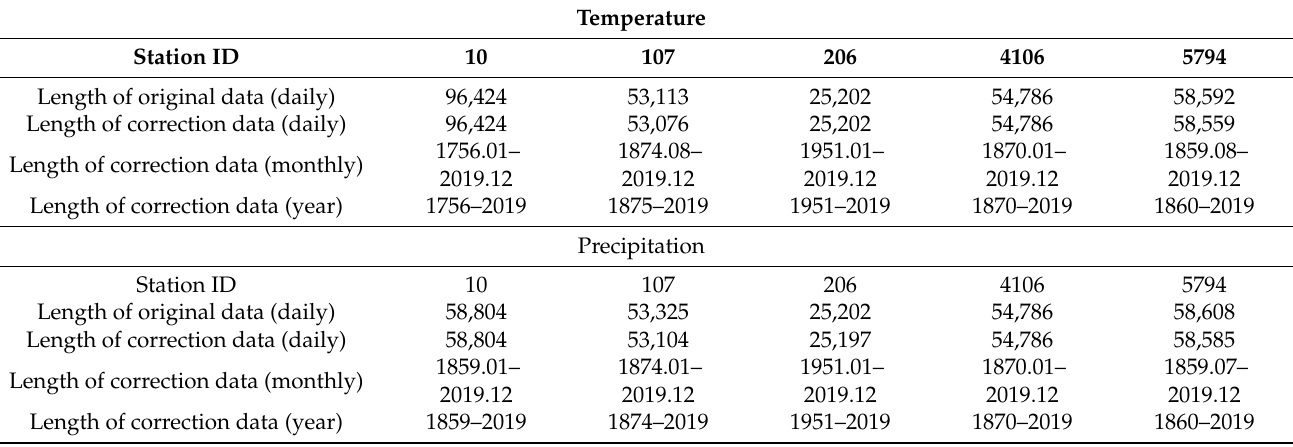
Table 2. Data processing information of the representative stations in areas around the Baltic Sea area.